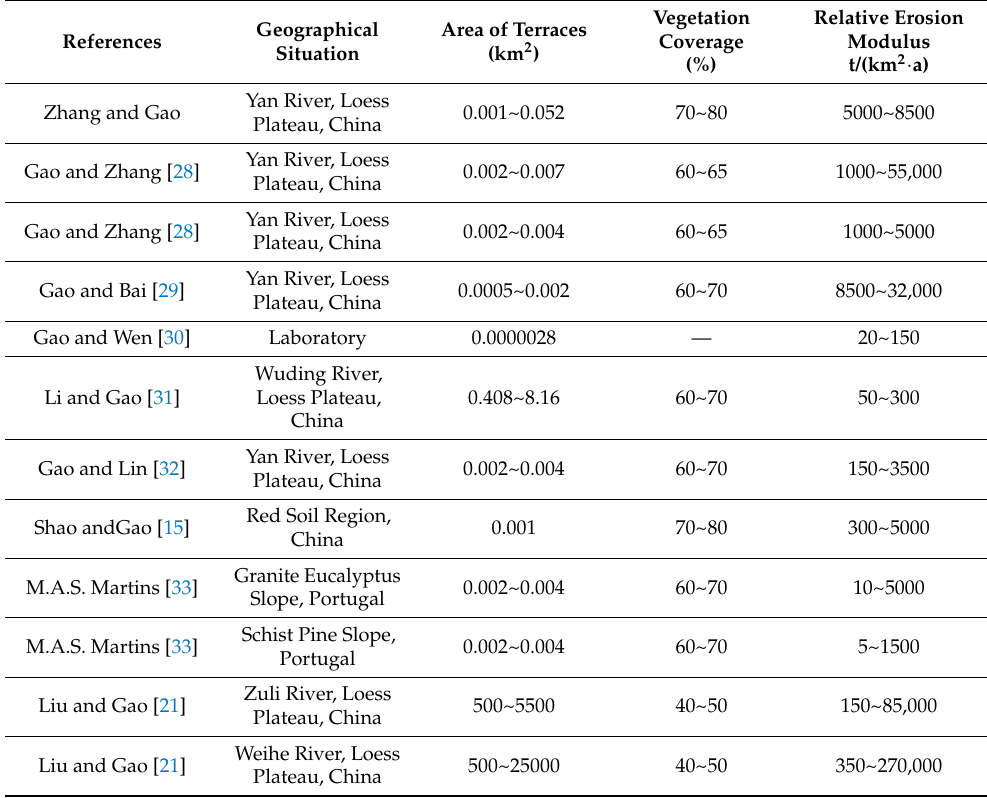
Table 8. Information about different